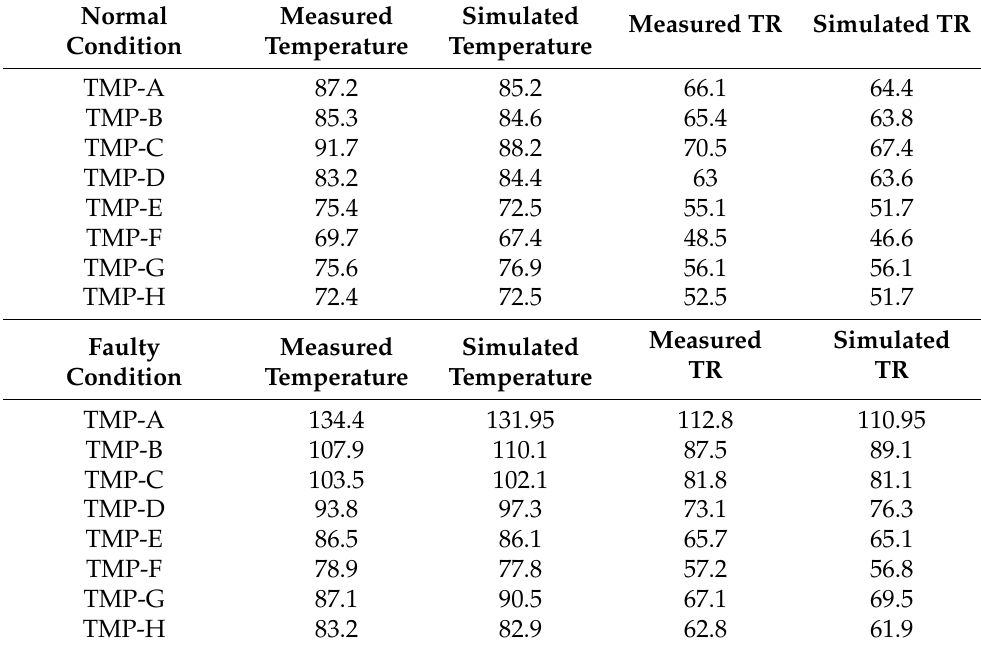
Figure 8 is the temperature distribution of the whole motor, stator core, and rotor before and after the fault. The comparison between Figure 8a,d shows that the hotspot